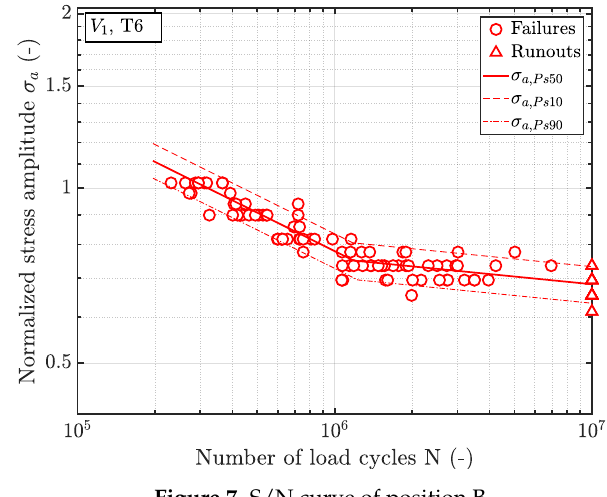
Figure 7. S/N curve of position B. Table 2. Evaluated results of the fatigue tests.